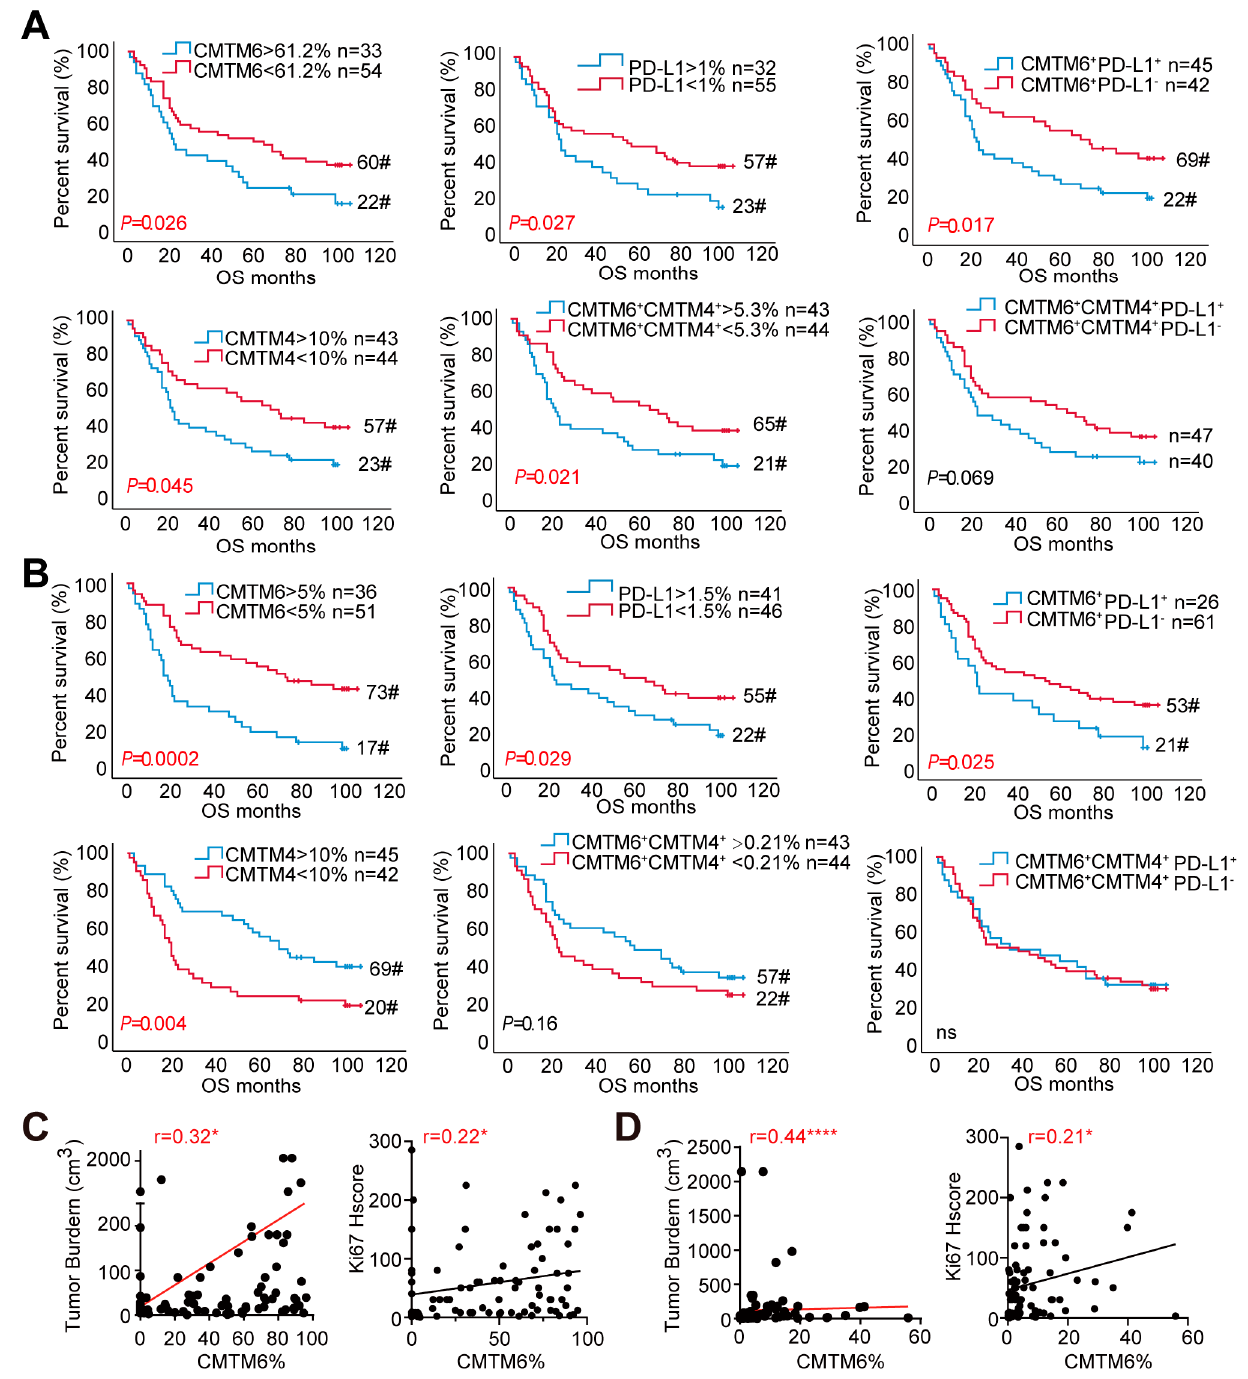
Figure 3. CMTM6 is associated with poor prognosis in the gastric adenocarcinoma. ( A , B ) Overall survival analysis of the above-mentioned tissue microarray samples by log rank test based on the expression of indicated molecules in the epithelial ( A ) and mesenchymal ( B ) regions. #, estimated median overall survival (months). ( C , D ) Correlation of CMTM6 and tumor burden as well as Ki-67 level in both epithelial ( C ) and mesenchymal ( D ) regions was calculated by the Spearman test. * p < 0.05, **** p < 0.0001.